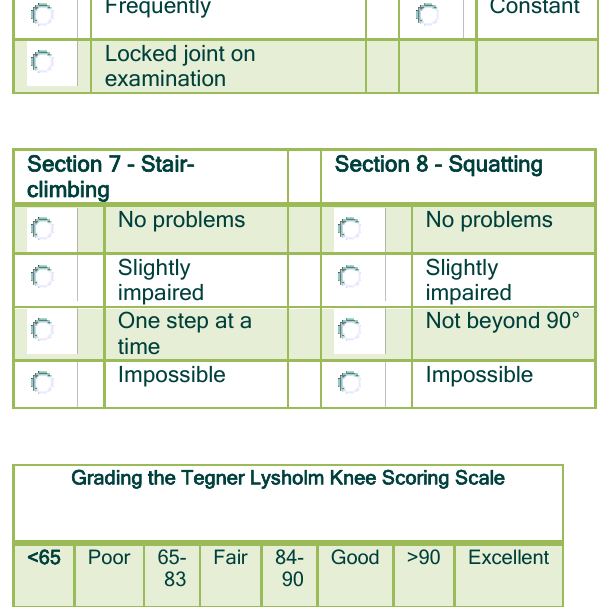
Tab. 1 : Tegner Lysholm scoring Scale Surgical procedure All of the patients treated by microfracture arthroscopic technique under general anesthesia and tourniquet applied .The marrow-stimulation technique required bed preparation by using a curette or a full- radius shaver